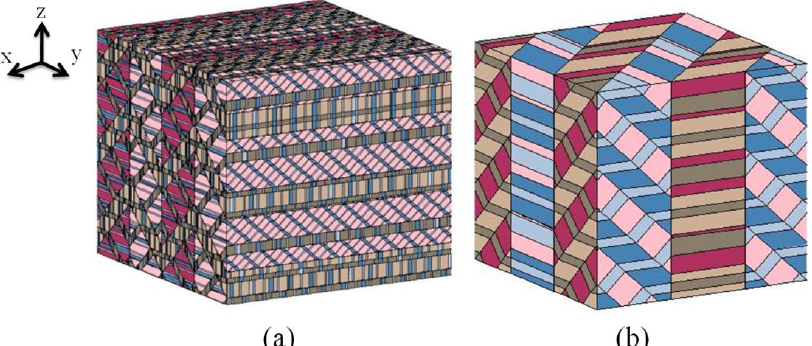
Figure 3. Schematic domain structures in a tetragonal crystal with all 6 types of domain present. (a) A rank-5 arrangement with average compatibility (b) A simpler, rank-3 arrangement with exact compatibility